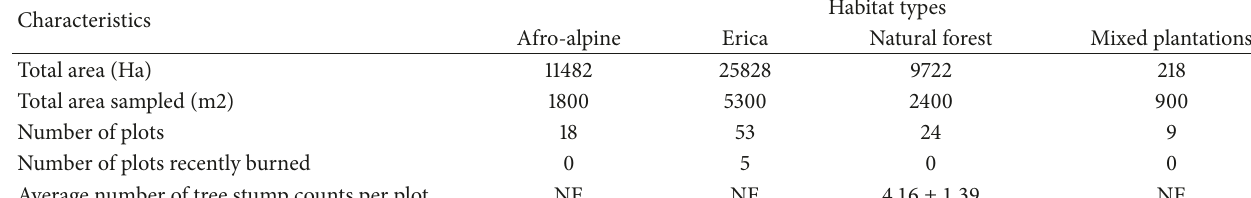
Table 1: Biophysical characteristics of sampling plots in the Galama block of the Arsi Mountains National Park. Characteristics